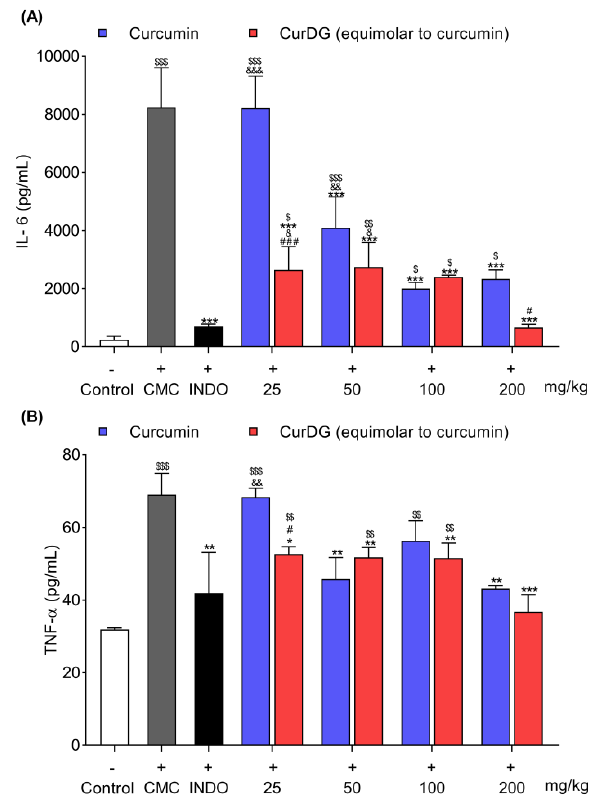
Figure 6. E ff ects of curcumin and CurDG on IL-6 ( A ) and TNF- α ( B ) levels in edema paw tissue. Results are shown as means ± SEM (n = 8 / group). Note: $ p < 0.05, $$ p < 0.01 and $$$ p < 0.001 compared to the naïve group; * p < 0.05, ** p < 0.01, and *** p < 0.001 compared to the carrageenan group; # p < 0.05 and ### p < 0.001 indicate significant di ff erences between curcumin- and CurDG-treated groups; & p < 0.05 and && p < 0.01 indicate statistical di ff erences in the treatment groups compared with the indomethacin-treated group